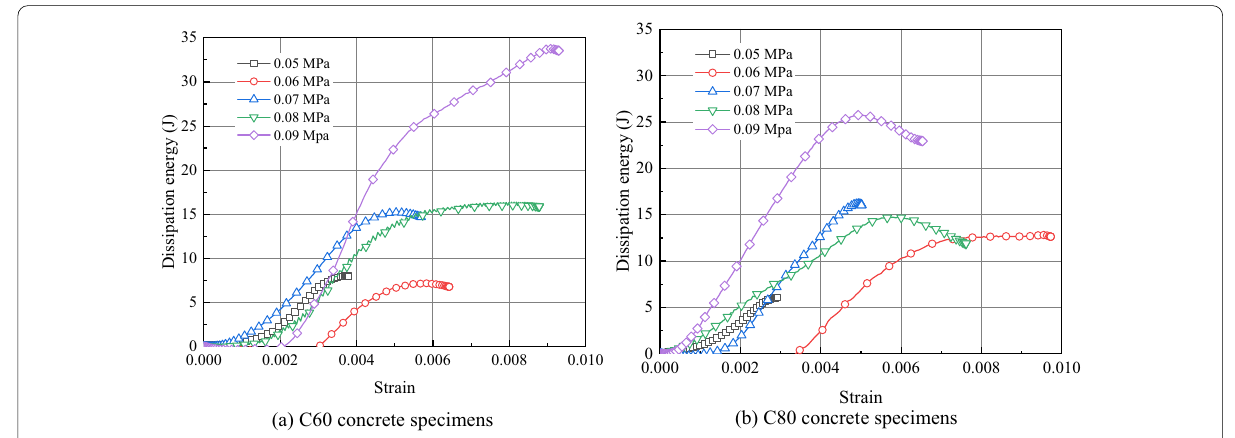
Fig. 9 Dissipative energy–strain characteristic curve of high-strength concrete.